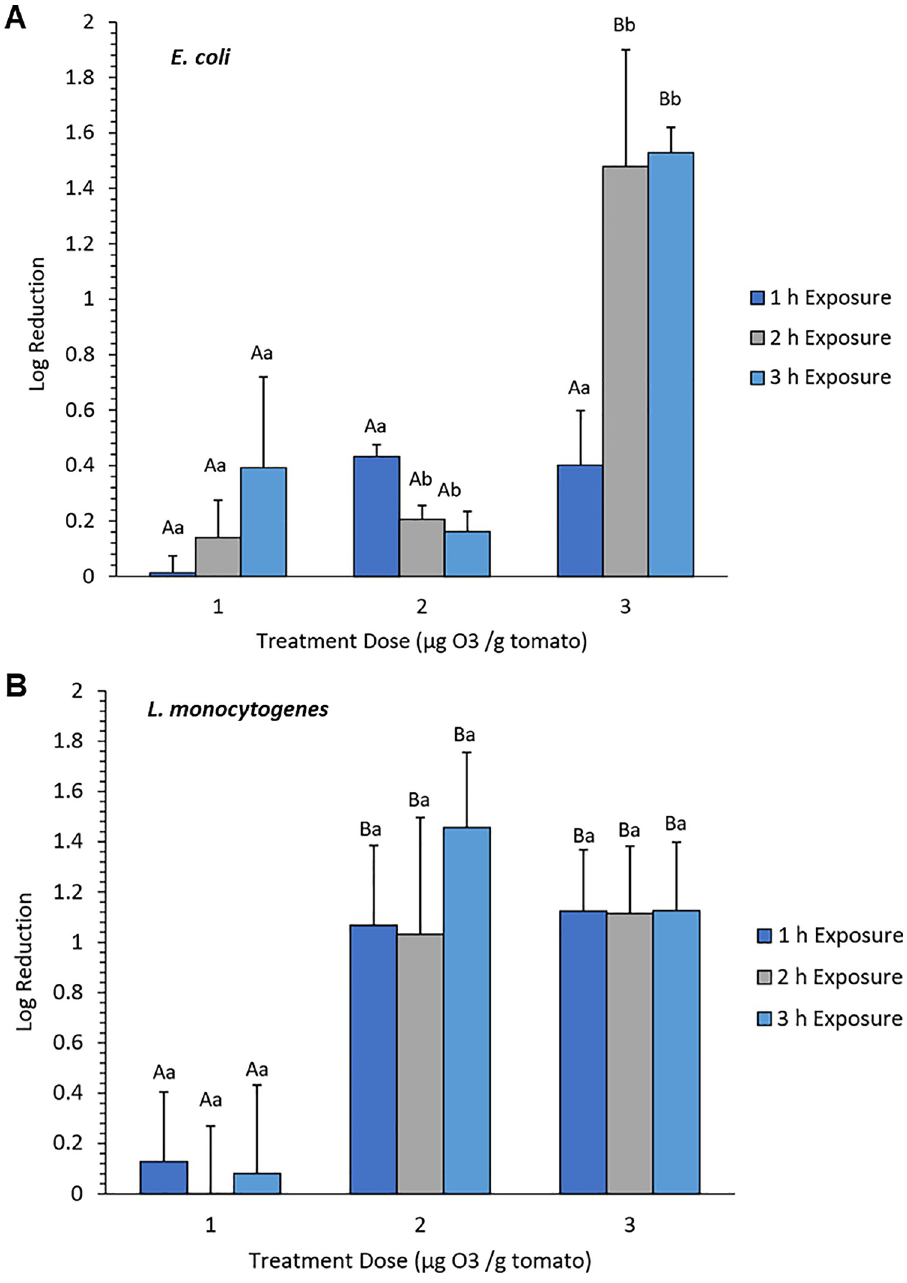
Fig 1. Growth reduction of E . coli (A) and L . monocytogenes (B) on non-host tomato treated with different doses of ozone (O 3 ) gas. Tomatoes harboring bacterial cells were treated with 1 μ g, 2 μ g, and 3 μ g O 3 per gram of ripe fruits. Capital letters indicate significant difference (P < 0.05) caused by O 3 doses at the same time-point. Lowercase letters indicate significant difference (P < 0.05) caused by time of exposure under the same O 3 dosage. across the temporal RNA-Seq datasets were normalized and transformed to Propensity Scores (PS). Pearson Correlation Coefficient (PCC) was further applied to PS in order to establish the significance of differentially expressed genes [30]. Based on the scatter plots of the global O response transcriptomes, similar patterns of transcriptional changes were evident over time